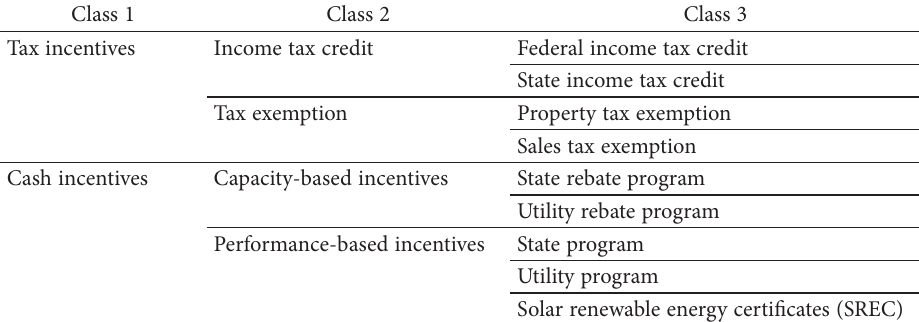
Table 1. Solar incentives in the